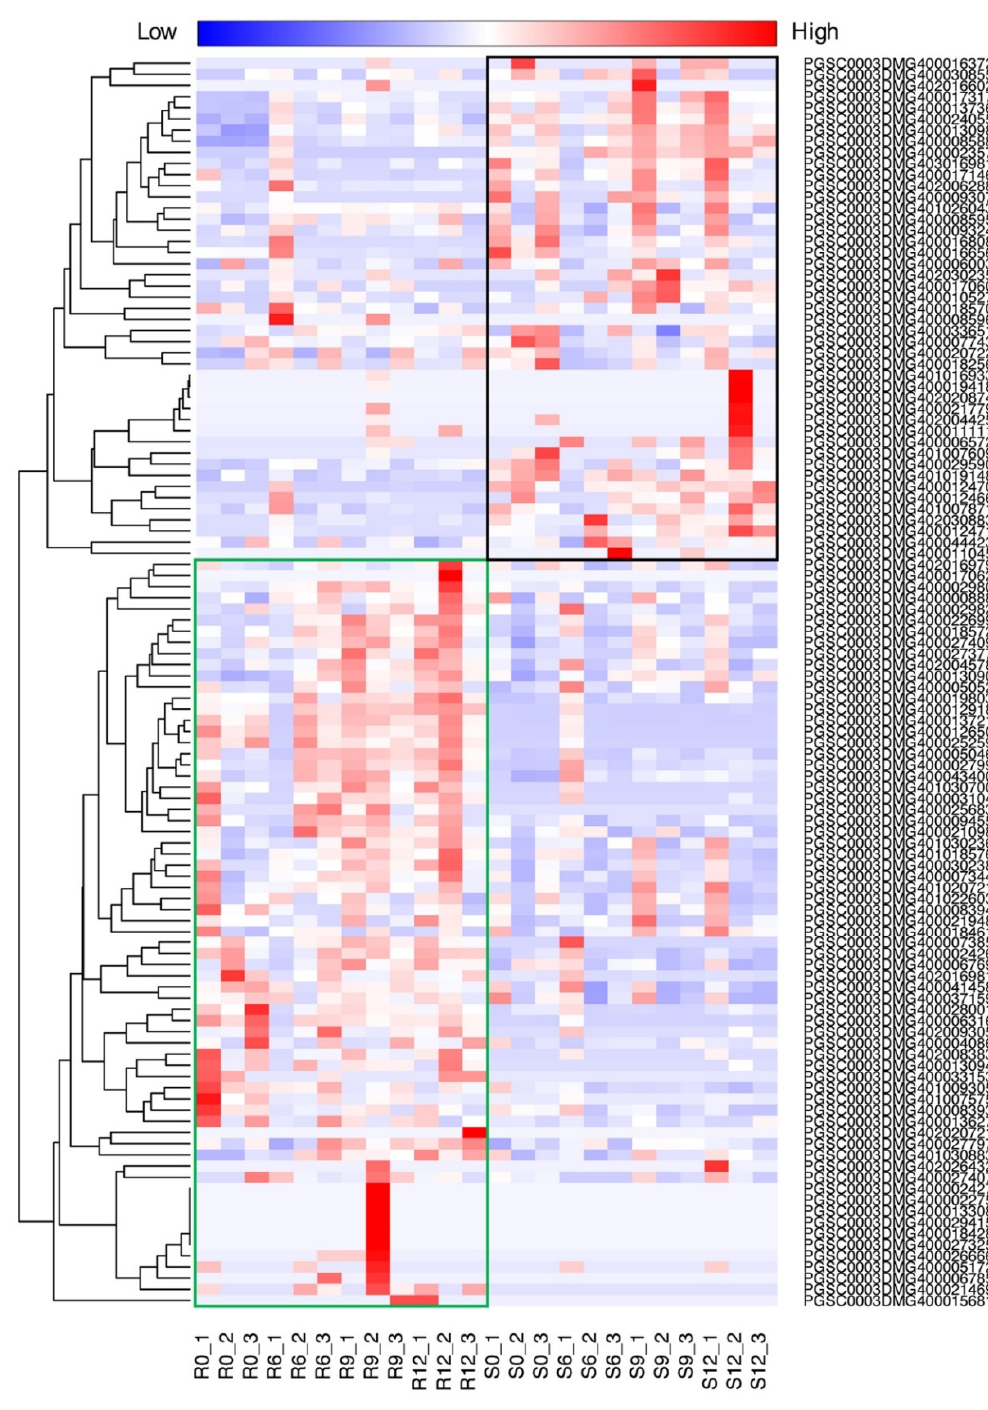
Figure 5. Expression profile of putative nucleotide-binding site and leucine-rich repeat (NLR) orthologous genes in infected S. pinnatisectum and S. cardiophyllum at 0, 6, 9, and 12 hpi. The heatmap indicates the sum of counts per million (CPM) values for genes in subclasses; the data are in Supplementary Material file S1. The green rectangle frame harbors most upregulated NLR genes in S. pinnatisectum . The black rectangle frame includes the most upregulated NLR genes in S. cardiophyllum . Each time point contains three replicates. R, refers to S. pinnatisectum ; S, refers to S. cardiophyllum .